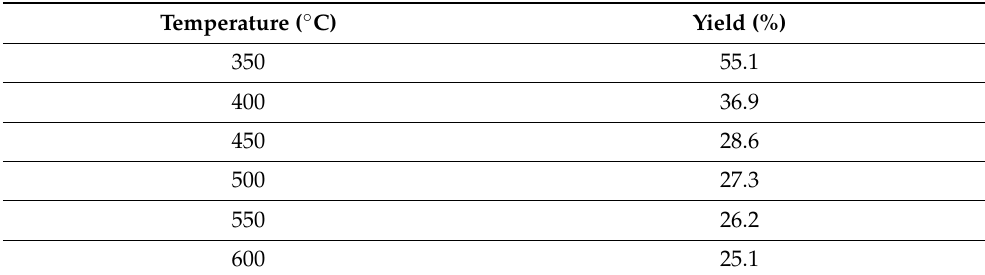
Table 2. Char yield at different